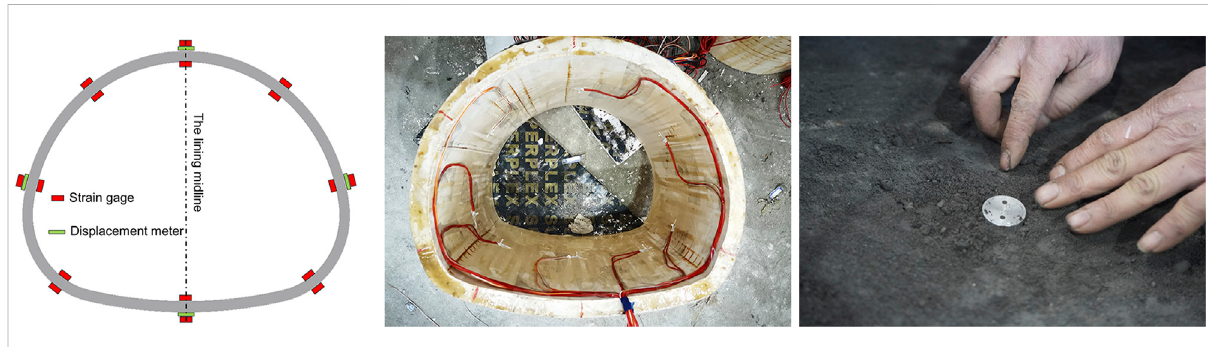
FIGURE 10 Measurement points layout.